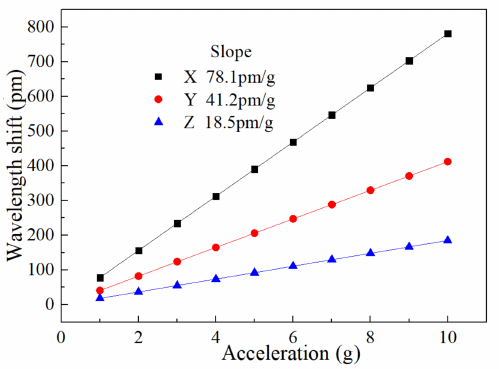
Figure 16. Wavelength shifts in the x-, y-, and z-directions as functions of acceleration